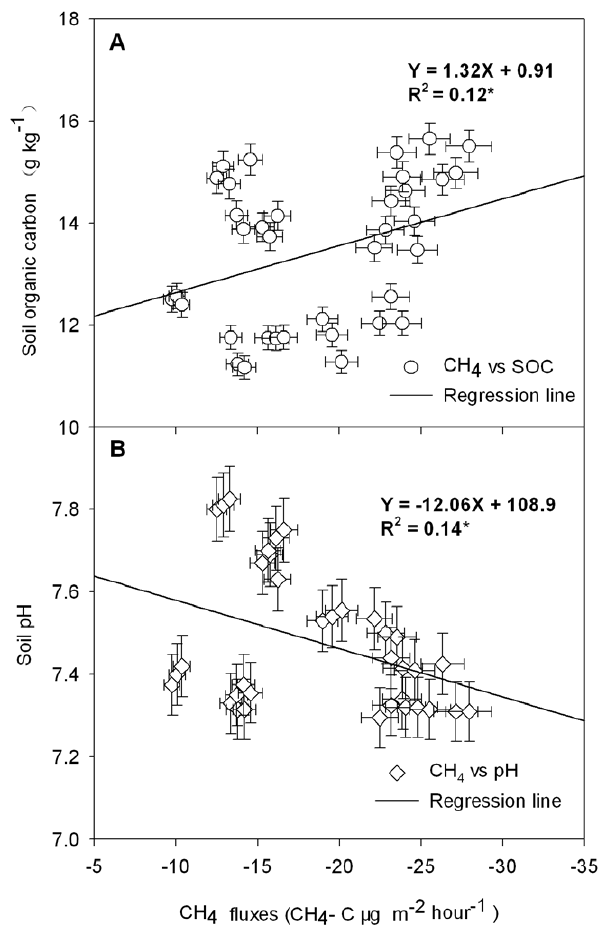
Figure 3. A Linear regression between the CH 4 uptake fluxes and SOC, B Linear regression between the CH 4 uptake fluxes and soil pH. Arrows indicate the regression equation between the CH 4 uptake fluxes and soil organic carbon, soil pH. *indicates P ,